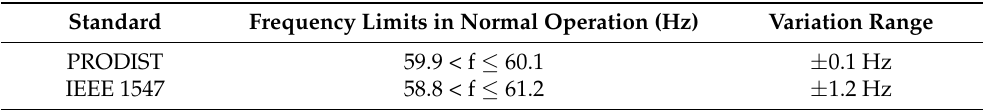
Table 1. Frequency limits—PRODIST vs. IEEE. Standard